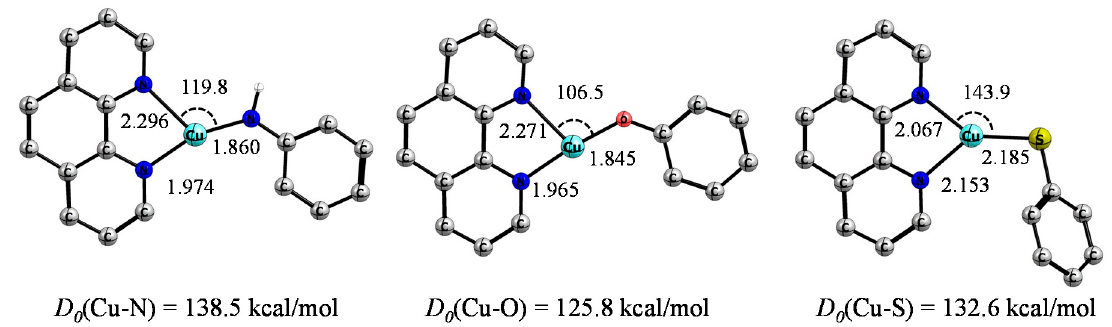
Figure 1. Optimized structures (B3LYP/def2-SVP) and bond dissociation energies D 0 (Cu-X) (B3LYP + D3(BJ)/def2-TZVPP//B3LYP/def2-SVP) for the complexes [(phen)Cu I (NHPh)], [(phen)Cu I (OPh)], and [(phen)Cu I (SPh)]. Bond lengths and angles are in [Å] and [ ◦ ], respectively. The hydrogen atoms attached to carbon atoms are omitted for clarity.